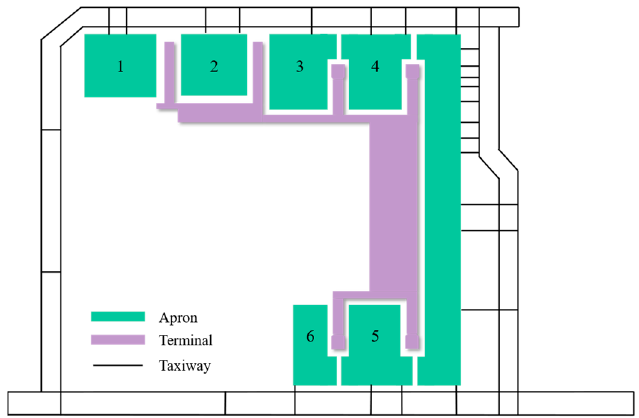
Figure 1. General Apron Layout of Wuhan Tianhe Airport. The main passenger apron at this airport contains 5 U-shaped areas (aprons 1–5 shown in the figure) and one semi-U-shaped area (apron 6 shown in the figure).